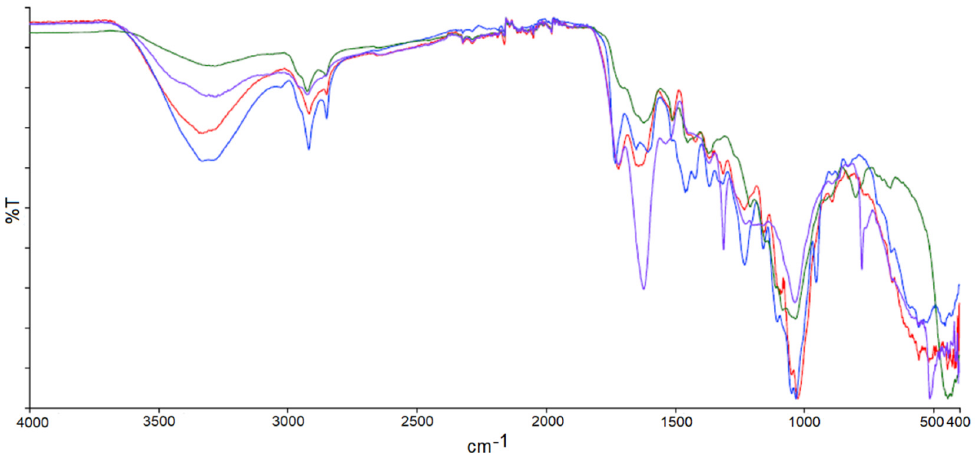
Figure A2. FTIR-ATR overlap of lignin fractions of all biomasses: Licorice Root (L, red), lignin Palm Leaf (P, blue), lignin Willow (W, green) and lignin Holm Oak (OH, purple). FTIR-ATR spectrum overlaps of the cellulose for all samples [19] is reported in Figure A3. All spectrums are similar and show a strong absorption band at 3300 cm − 1 which is ascribed to hydroxyl group stretching. Bands at 2900 cm − 1 and 1320 cm − 1 are relative to stretching vibrations of the -C-H group in the glucose element. The peak band at 900 cm − 1 is representative of the β -glycosidic linkage between glucose units. The signal at 1020 cm − 1 is assigned to -C-O functionality of ether functions and secondary alcohols characteristic of the cellulose chain backbone. In contrast, hemicellulose was isolated by alkaline extraction [20].